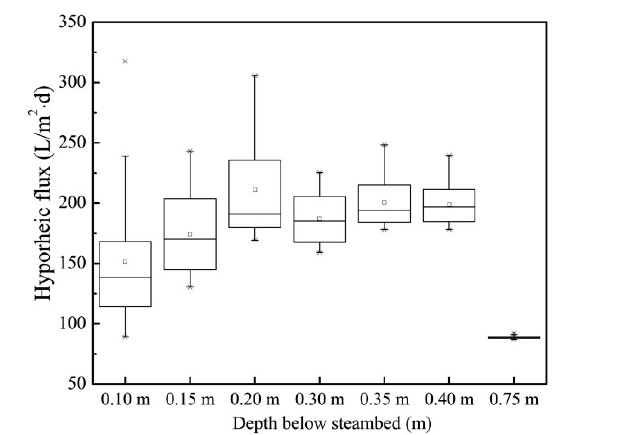
Fig. 5 Box-whisker plot of vertical hyporheic flux at different